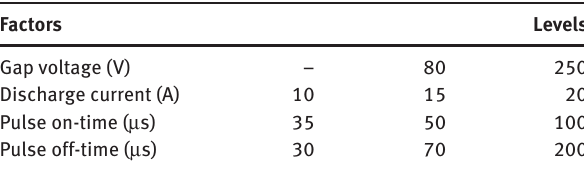
Table 4: Input parameters of EDM and designated levels. Factors